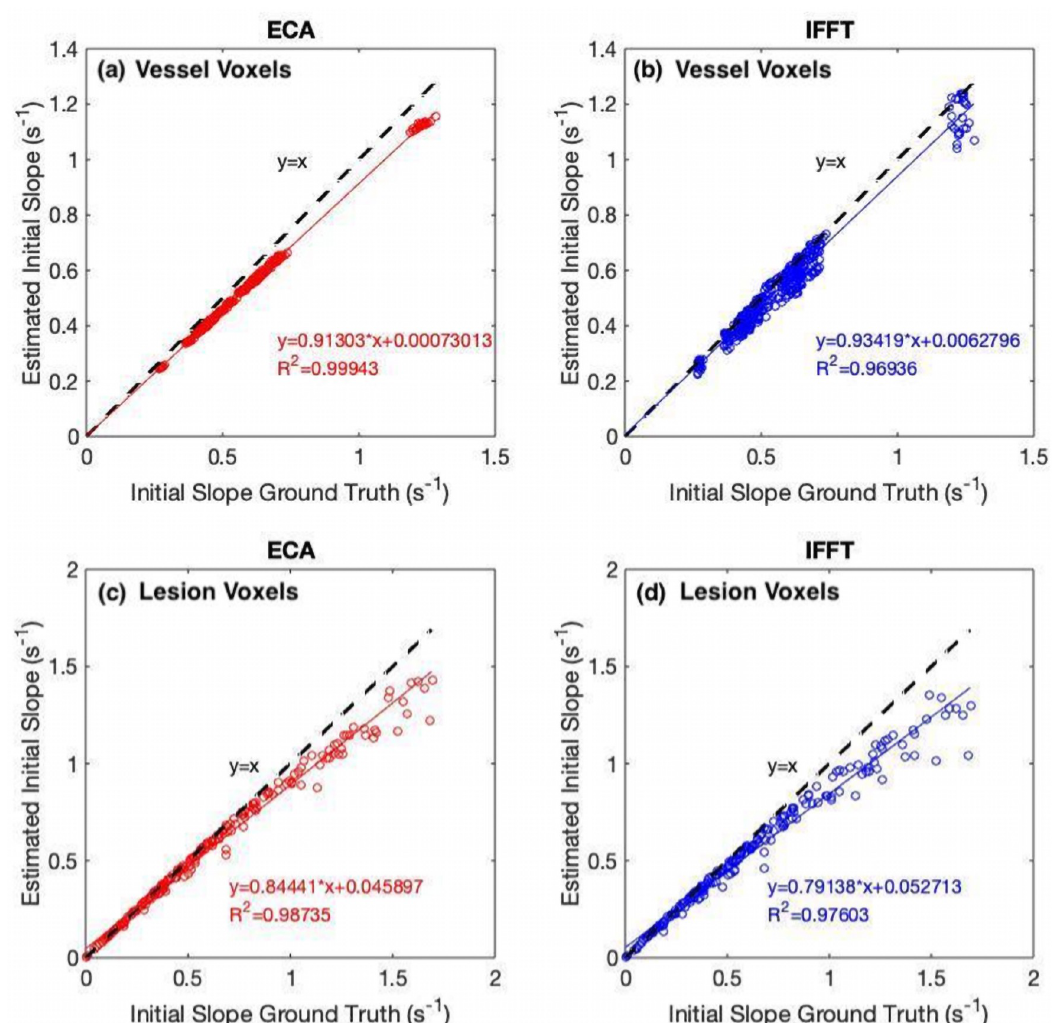
Fig 9. Scatter plot between ground truth initial slope and estimated initial slope. The panels show ECA and standard IFFT in (a) (b) vessels voxels and (c)(d) lesion voxels. The red lines and blue lines represent the linear correlations and black dashed lines show unity.